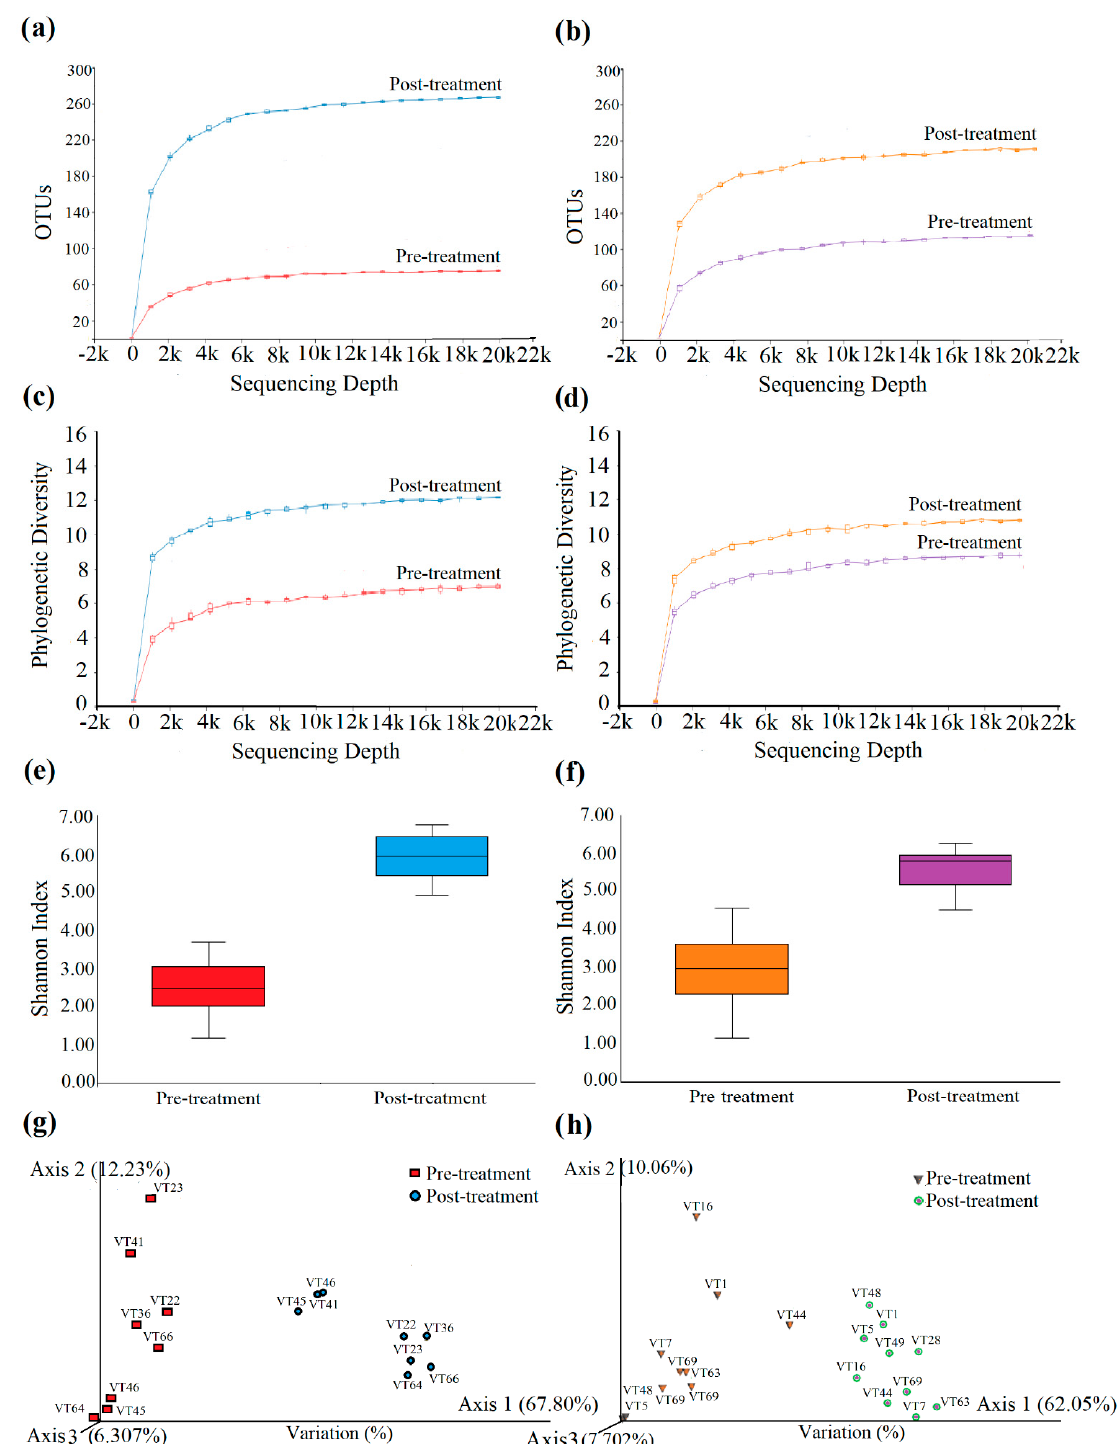
Figure 6. Refraction analysis for the G1 and G2 samples. The rarefaction curves of observed OTUs and Pathway diversity were computed for G1 ( a , c ) and G2 ( b , d ). Shannon H-index alpha Diversity was measured and compared for the G1 ( e ) and G2 ( f ) samples. The inter and intragroup species differences were compared using PCoA for G1 ( g ) and G2 ( h )